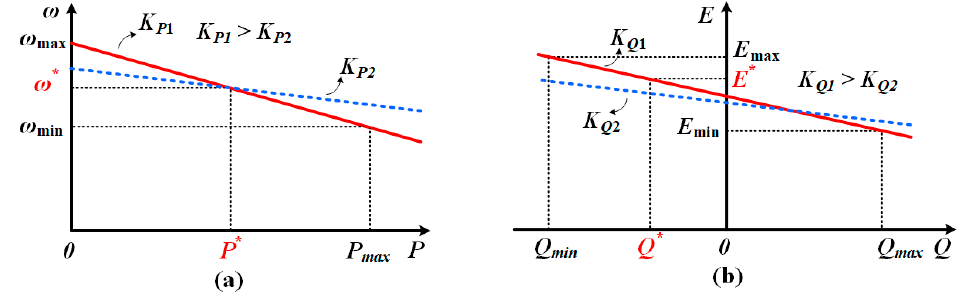
Figure 2. The conventional droop model of inductive output inverter according to ( a ) P - ω and ( b ) Q - E curve.